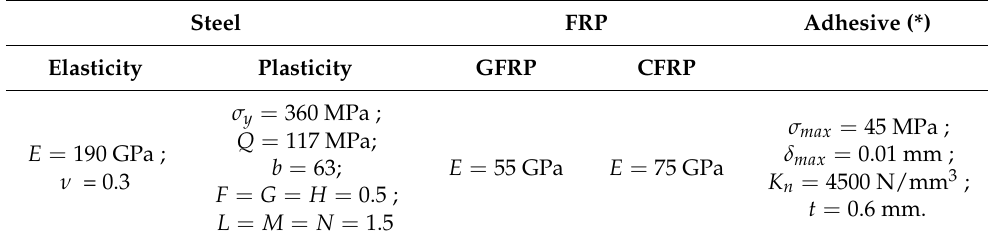
Figure 2. Typical traction-separation response .